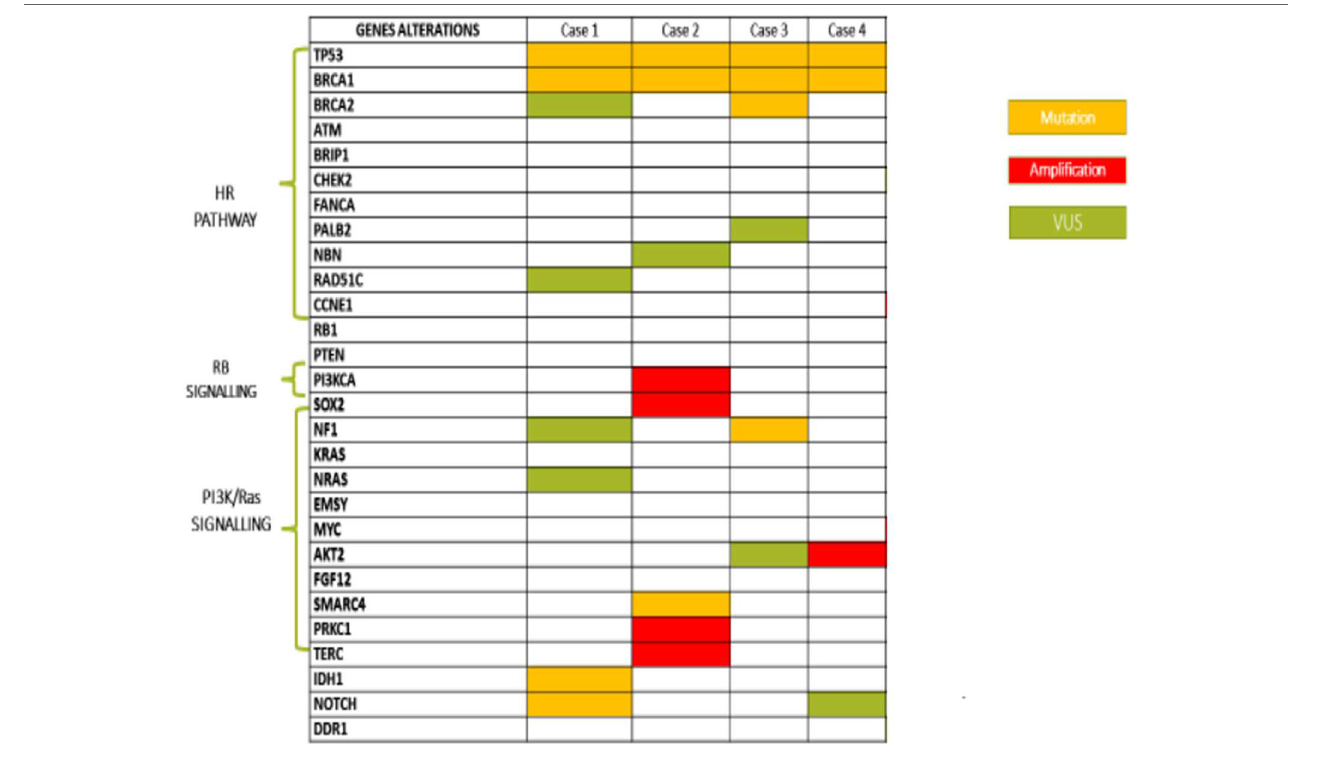
TABLE 2 | List of mutations